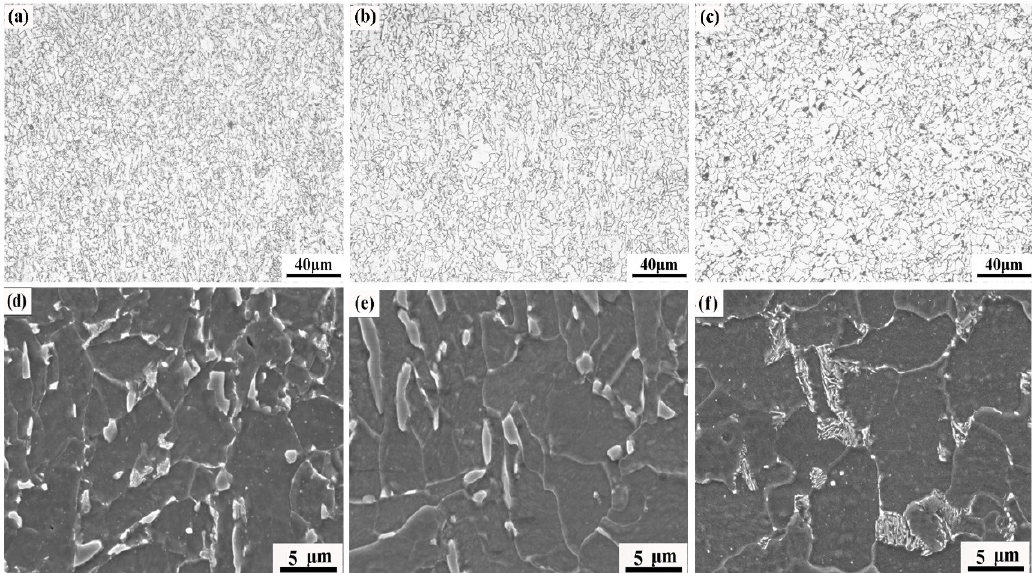
Figure 7. The microstructure of X70 steel after quenching at different isothermal temperatures ( a , d ) 480 ◦ C; ( b , e ) 500 ◦ C ( c , f ) 550 ◦ C.